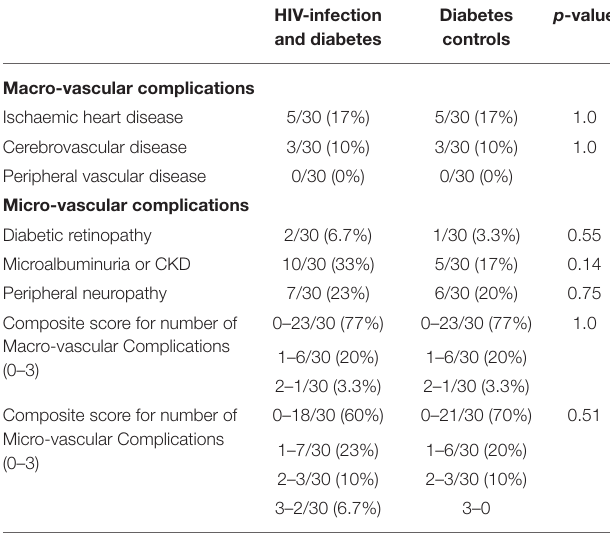
TABLE 6 | Macro and micro-vascular complications of diabetes clinic attendees wtih HIV-infection and diabetes vs. diabetes